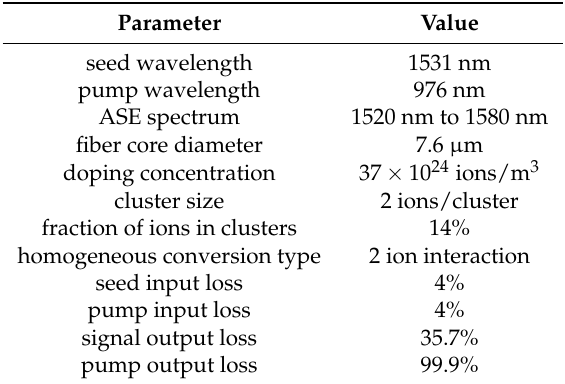
Table 3. Simulation parameters used for all fibers in the FLAT